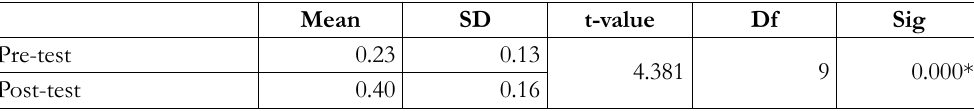
Table 5. Paired Sample t-test Analysis (Pre-and-Post-tests) of the Problem